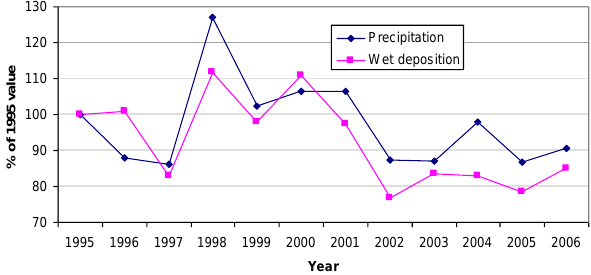
Fig. 7. Calculated annual deposition to the Baltic Sea basin of: Fig. 7 . Calculated annual deposition to the Baltic Sea basin of: oxidized dry, oxidised wet, oxidized dry, oxidised wet, reduced dry and reduced wet nitrogen reduced dry and reduced wet nitrogen in the period 1995 – 2006. Units: Gg N per year. in the period 1995–2006. Units: GgN per year.